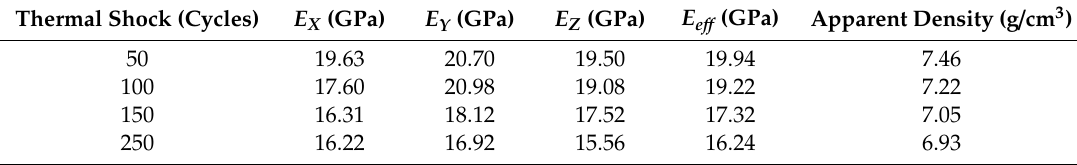
Table 5. The elastic modulus in three directions, the e ff ective elastic modulus and apparent density. Thermal Shock